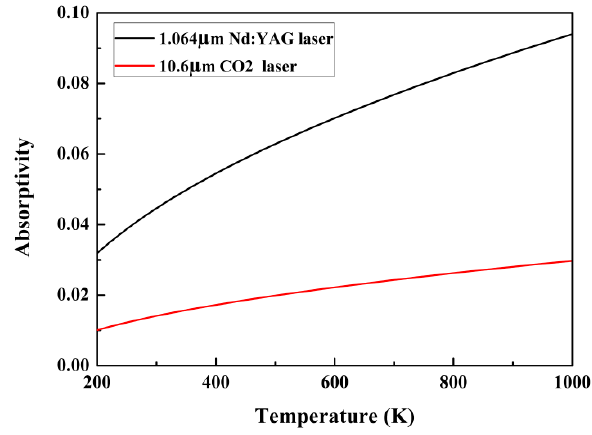
Figure 1. Absorptivity of Cu for the CO 2 and Nd:YAG laser.